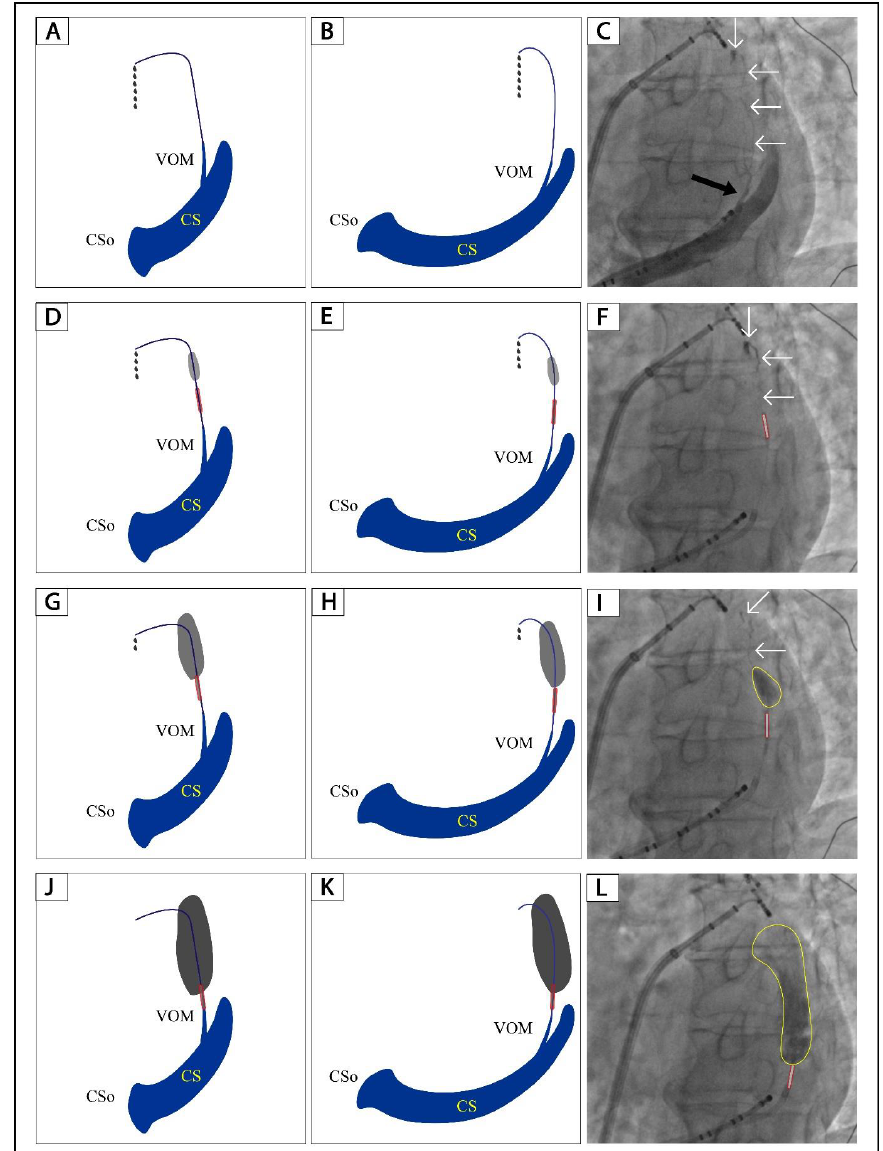
Figure 5. A step-by-step illustration of ethanol infusion in a VOM with collateral circulation. ( A , B ): Schematic diagram of non-occluded venograms of VOM in the RAO and LAO projection, respectively. ( D , G , J ): Schematic diagram of balloon occluded venograms of VOM in the RAO projection after 2, 4, and 8 mL of ethanol infusion, respectively. ( E , H , K ): Schematic diagram of balloon occluded venograms of VOM in the LAO projection after 2, 4, and 8 mL of ethanol infusion, respectively. ( C ): Non-occluded venogram of VOM in the LAO projection. ( F , I , L ): Balloon occluded venograms of VOM in the RAO projection after 2, 4, and 8 mL of ethanol infusion, respectively. The black arrow indicates the ostium of VOM. The white arrows indicate the drainage of the VOM. The tubule outlined in red indicates the angioplasty balloon. The gray and black shadows in Panels ( D , E , G , H , J ) and yellow circles in Panels ( I , L ) indicate localized myocardium staining. The black dots in Panels ( A , B , D , E , G , H ) indicate contrast leakage through the collateral circulation. VOM, the vein of Marshall; RAO, right anterior oblique; LAO, left anterior